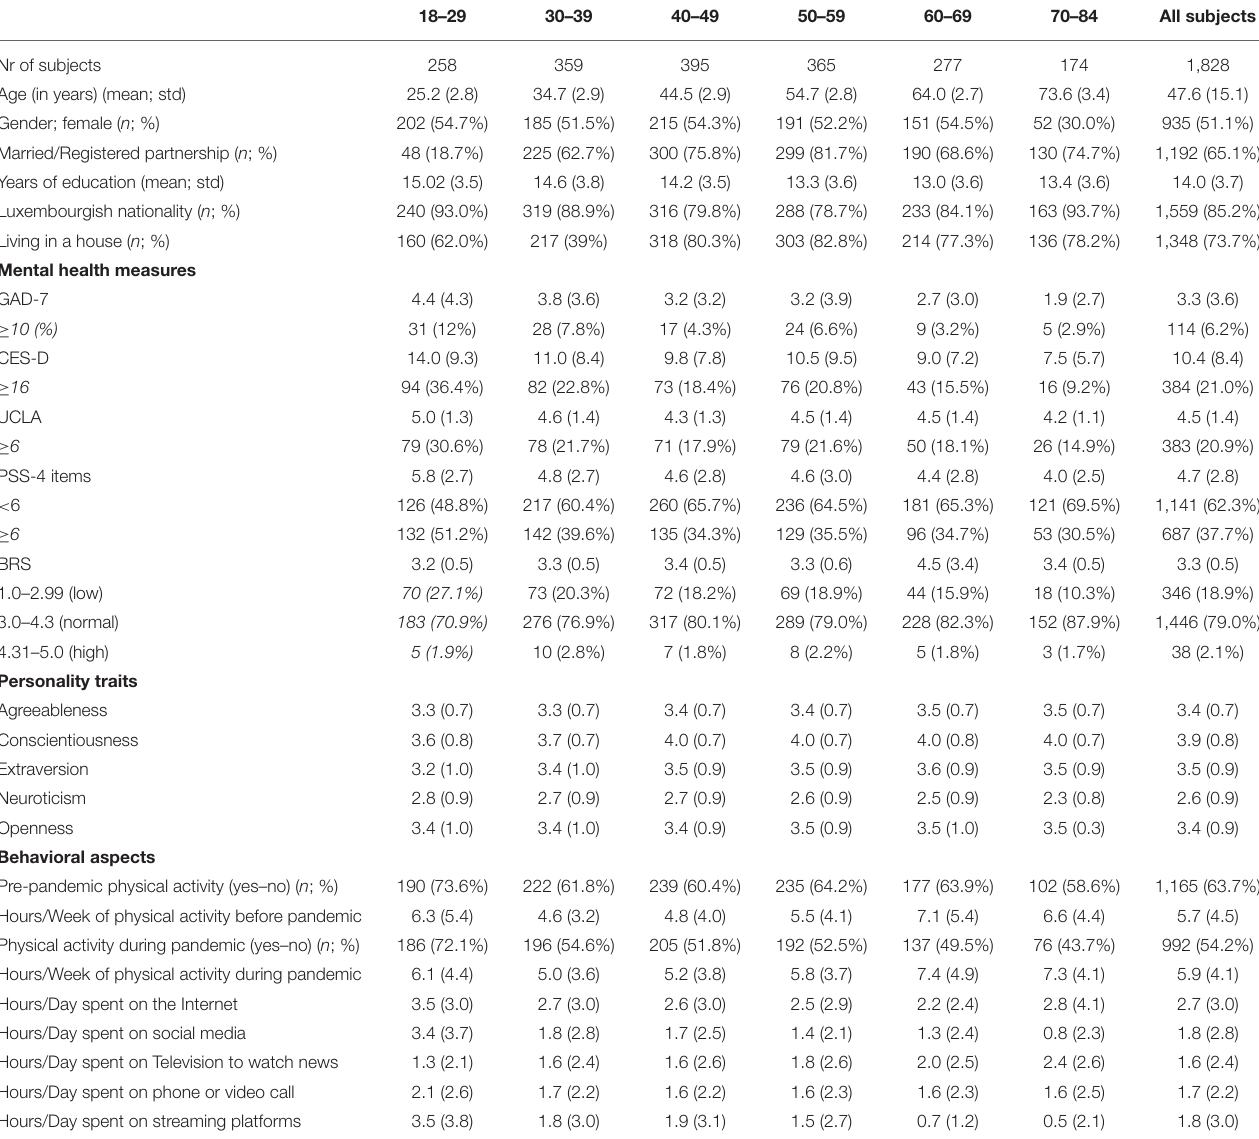
TABLE 1 | Demographic characteristics, psychological measures, personality traits, and behavioral aspects by age